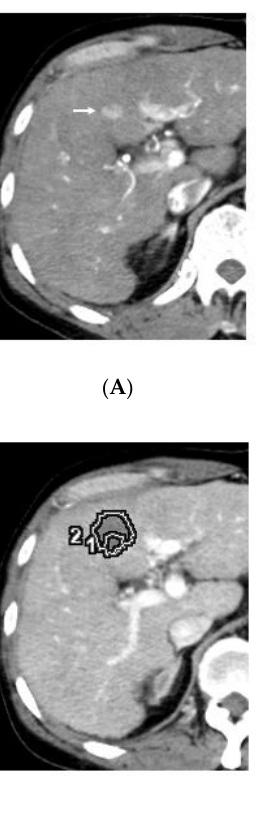
Figure 2. Changes in the classification of early treatment response reevaluation of RFA using overlay fused CT/MRI imaging.